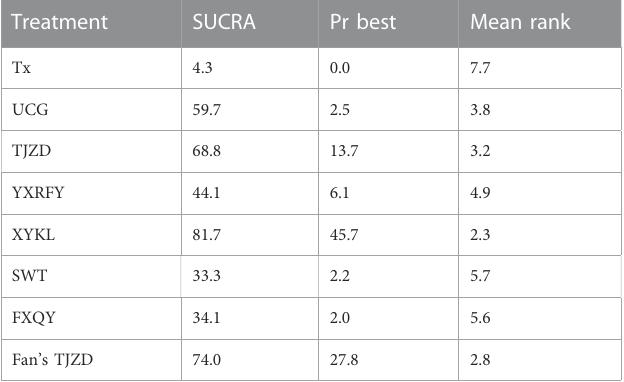
TABLE 3 SUCRA ranking of visual analog scale in Chinese herbal medicine treatment in dialysis patients.